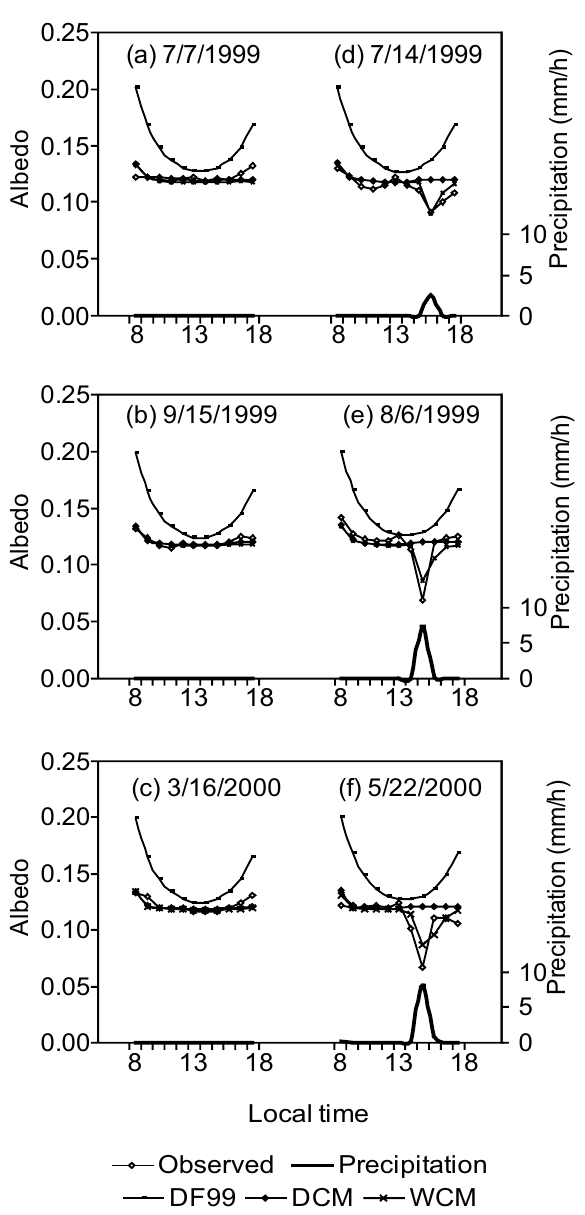
Fig. 2 – Diurnal variation of the simulated and observed surface albedo in the Cuieiras Reserve for the selected days. by water and dry canopy surfaces individually applied to leaves and stems) are